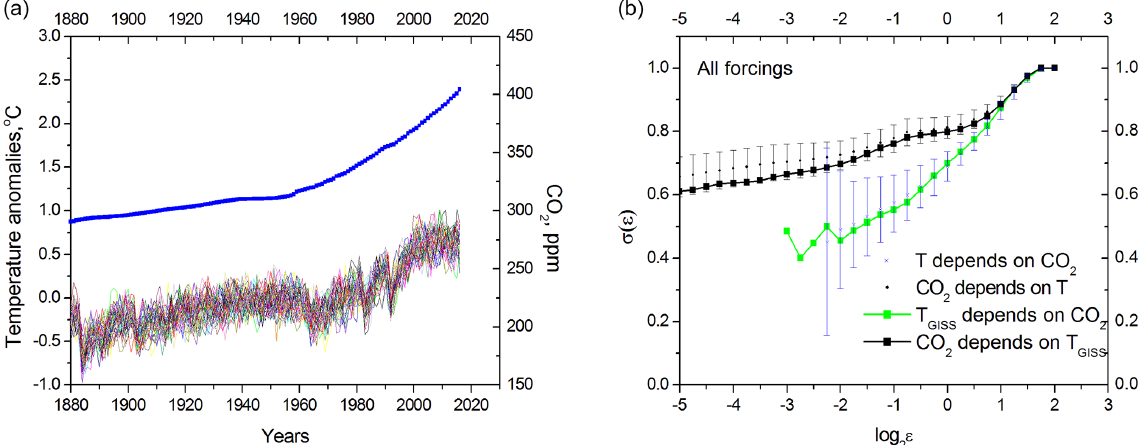
Figure 3. Detecting causality in model simulations. Anthropogenic and natural (volcanic and solar) forcing. (a) Surrogates of model temper- ature deviations induced by both natural and anthropogenic forcing together with carbon dioxide concentration measurements (CO2 NASA GISS Data, 2016). (b) Conditional dispersion of the Northern Hemisphere temperature and carbon dioxide concentration. The black curve is the conditional dispersion of the carbon dioxide concentration instrumental measurements; the green curve represents conditional dispersion of the Northern Hemisphere temperature measurements (same as in Fig. 2b). The blue crosses are the mean of 50 multimodel surrogates’ conditional dispersions of the Northern Hemisphere temperature; small black dots are the mean of 50 multimodel surrogates’ conditional dispersions of carbon dioxide. Bars represent doubled standard